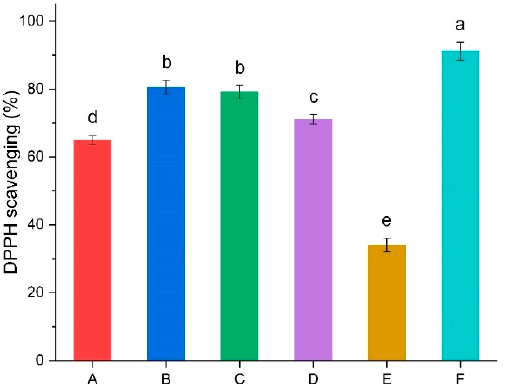
Figure 2. Antioxidant activity of ABT synbiotic yoghurt with different citrus peel addition. (A): ABT synbiotic yoghurt without citrus peel addition (control), (B): ABT synbiotic yoghurt with 0.5% SO peel addition, (C): ABT synbiotic yoghurt with 0.5% SWO peel addition, (D): ABT synbiotic yoghurt with 0.5% LO peel addition, (E): unfermented milk, (F): ascorbic acid. Different letters in the same column indicate a significant difference between the treatments at p < 0.05.